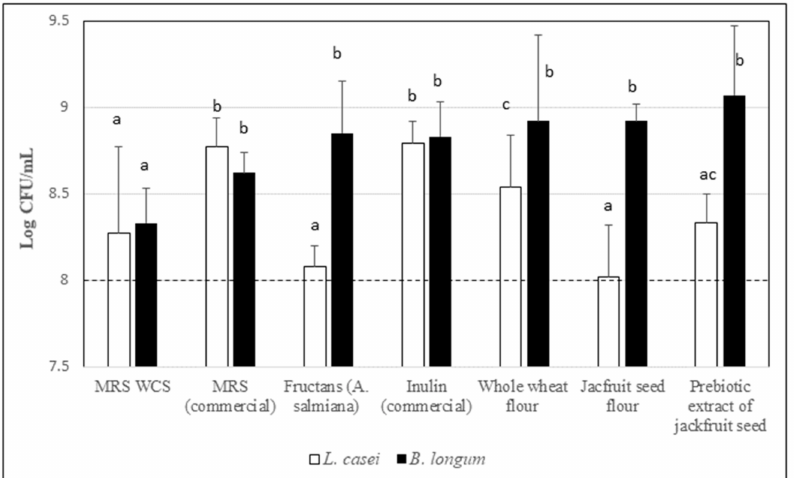
Figure 4. Prebiotic activity of jackfruit seed flour and prebiotic extract of jackfruit seed, compared with A. salmiana fructans, commercial inulin, whole wheat flour, commercial MRS and MRS without carbohydrates source (MRS-WCS). The values are the means ± S.E. Data with different letters are significantly different at p <